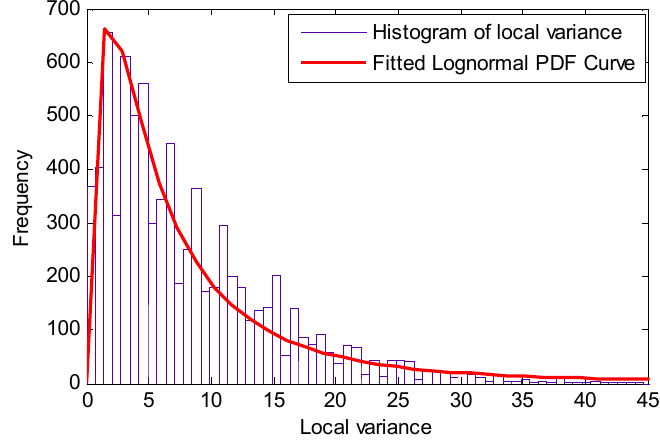
Figure 7. Probability distribution function of local variance.